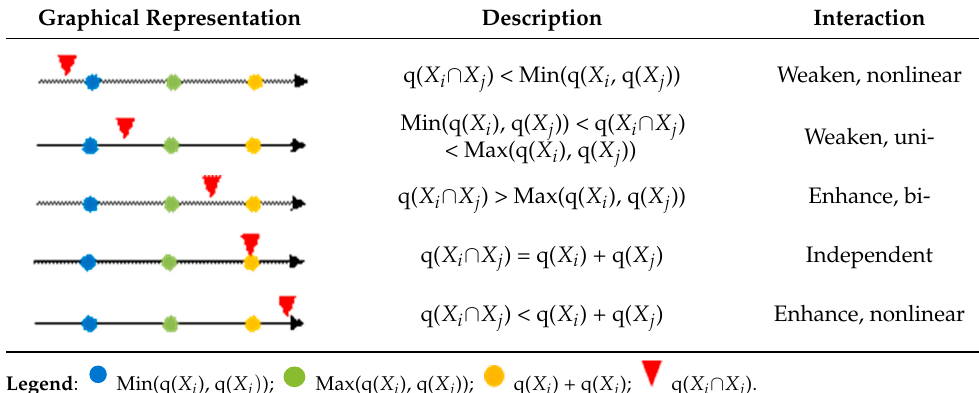
Table 1. Interaction between Explanatory Variables. Graphical Representation